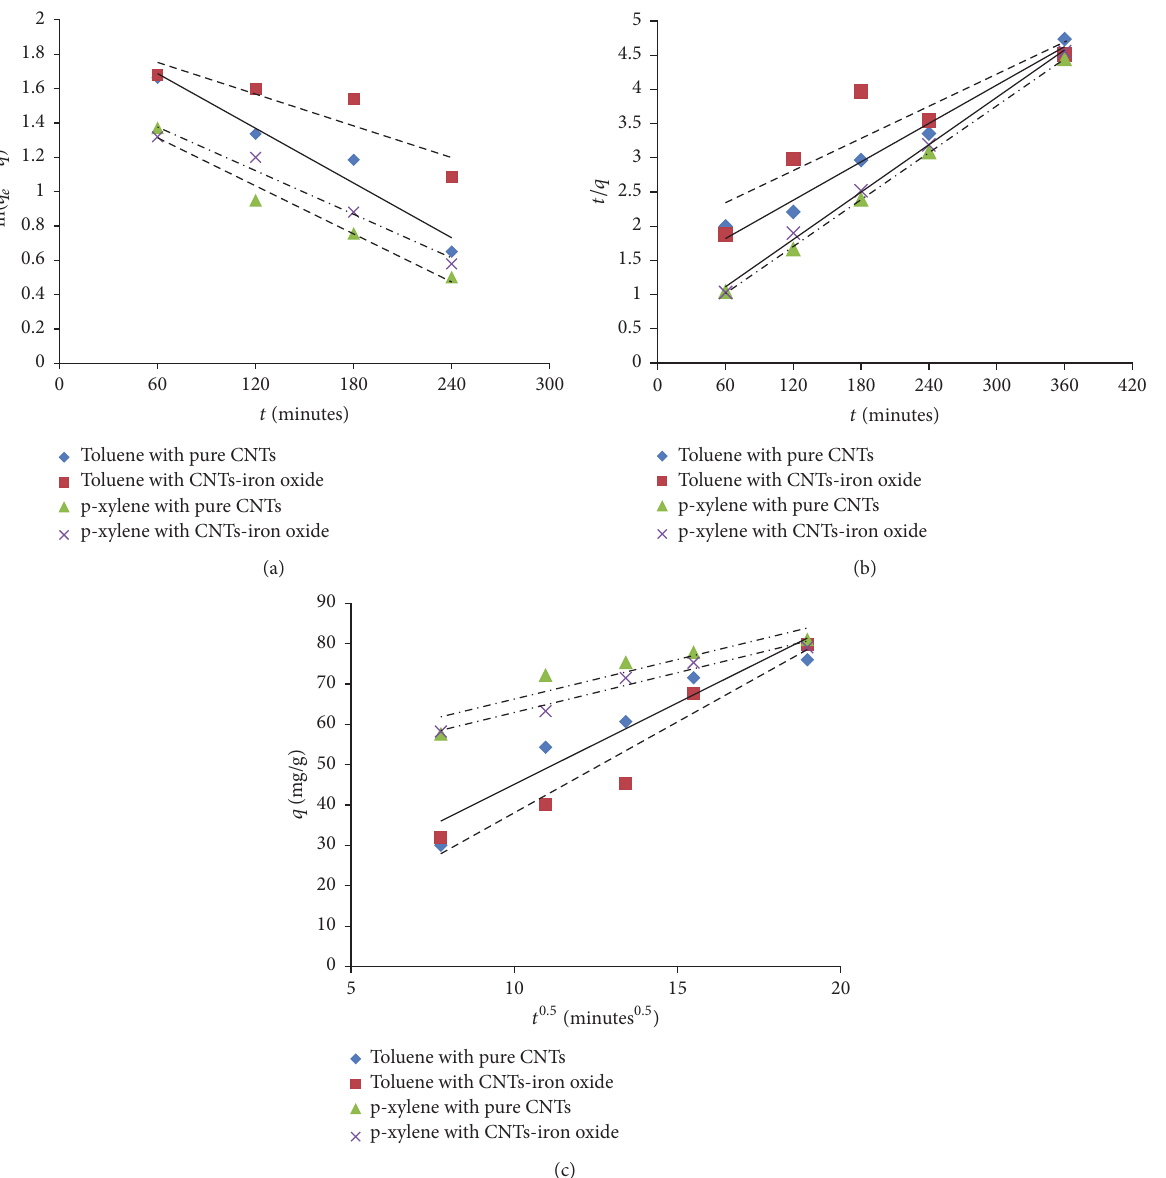
Figure 9: Adsorption kinetics model fitting using (a) pseudo-first-order, (b) pseudo-second-order, and (c) intraparticle diffusion model for toluene and